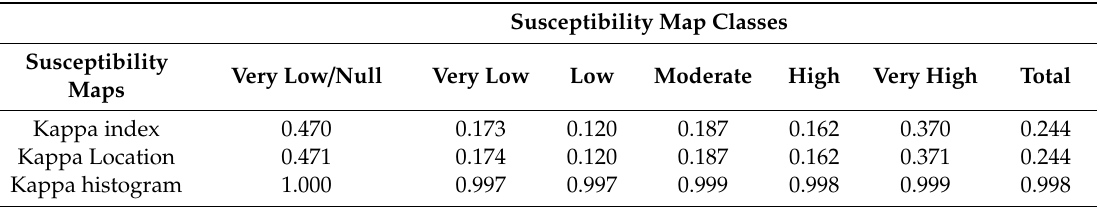
Table 4. Kappa values obtained by comparing the susceptibility Model B1 vs. Model B2.